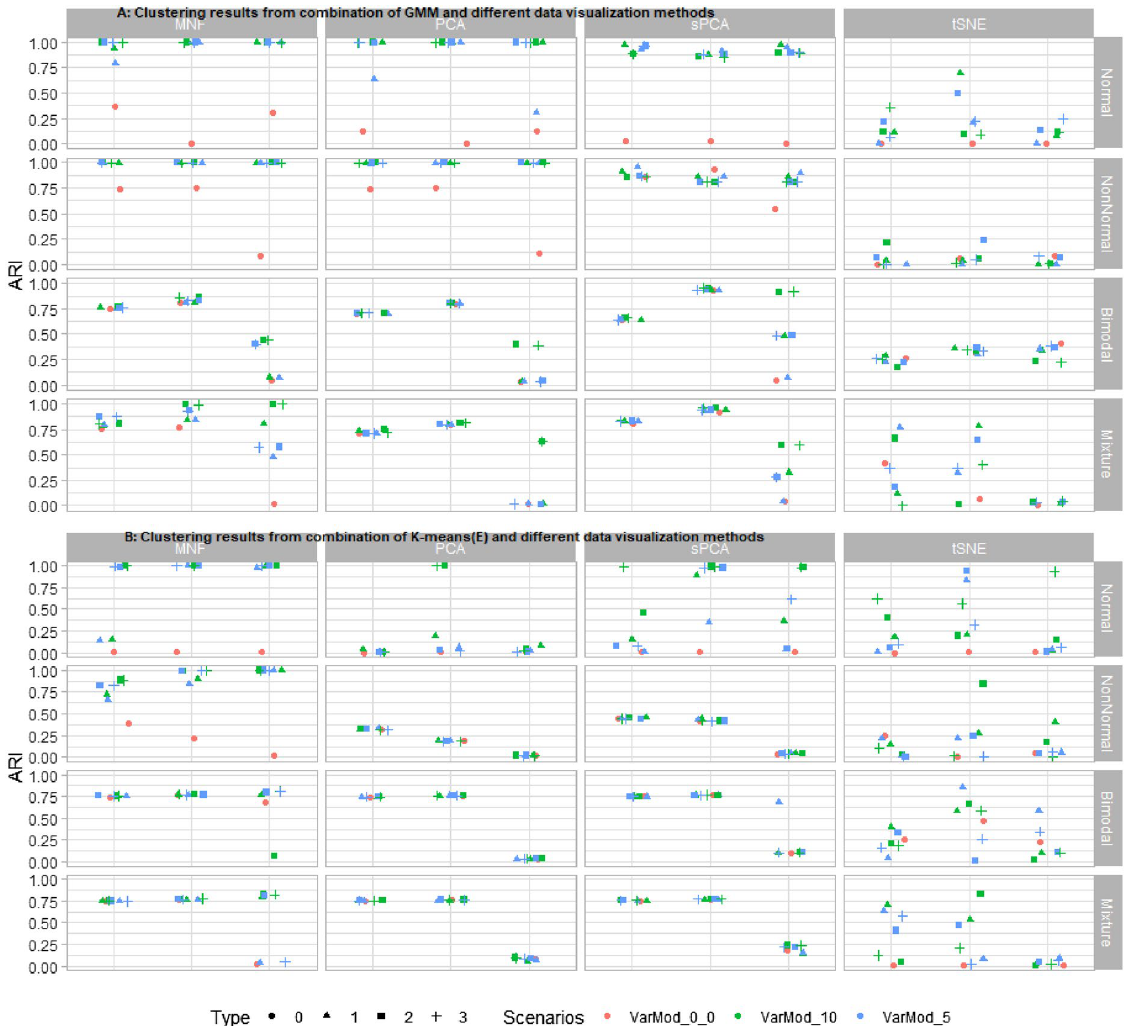
Figure 5. A plot of simulation results from the combination of dimension reduction techniques and clustering methods. Four different dimension reduction techniques (MNF, PCA, sPCA, and t-SNE) were implemented on synthetic data before cluster analysis. Cluster analysis was performed with ( A ) GMM and, ( B ) Kmeans(E) methods. The performance of clustering methods is monitored based on their adjusted rand index (ARI) value. In the above figure, the ‘Scenarios’ represent the number of variables with updated mean values in synthetic data, such as VarMod_0, all variables in synthetic data with zero mean; VarMod_10, 10 variables in synthetic data with mean value 0.5; VarMod_5, 5 variables in synthetic data with mean value 0.5. And the ‘Type’ represents the nested conditions with scenarios (0, all variables with mean 0; 1, variables with updated means in single cluster (VarMod_0_5, VarMod_0_10); 2, variables with updated means in both clusters (VarMod_5_5, VarMod_10_10); 3, simulation with added noise (VarMod_5_5_addnoise, VarMod_10_10_addnoise). The details of the statistical and spatial parameters modified are given in Fig. 2.